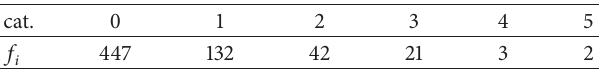
Table 6: Empirical frequency distribution for the second example dataset.